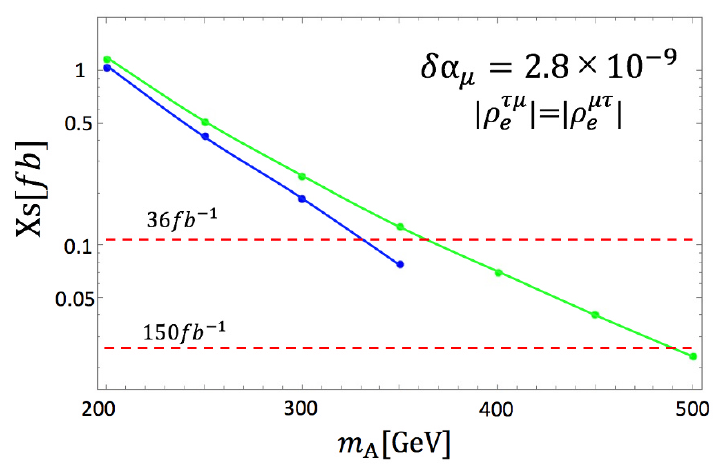
Figure 4 . The (cid:28) (cid:6) (cid:28) (cid:6) (cid:22) (cid:7) (cid:22) (cid:7) signal cross section after the selection cut as a function of m A . We show the two cases j (cid:26) (cid:28)(cid:22) j = j (cid:26) (cid:22)(cid:28) j = 0 : 3 (blue), and 0 : 6 (green). The other parameters are (cid:12)xed to e e reproduce the required deviation of (cid:14)a (cid:22) = 2 : 8 (cid:2) 10 (cid:0) 9